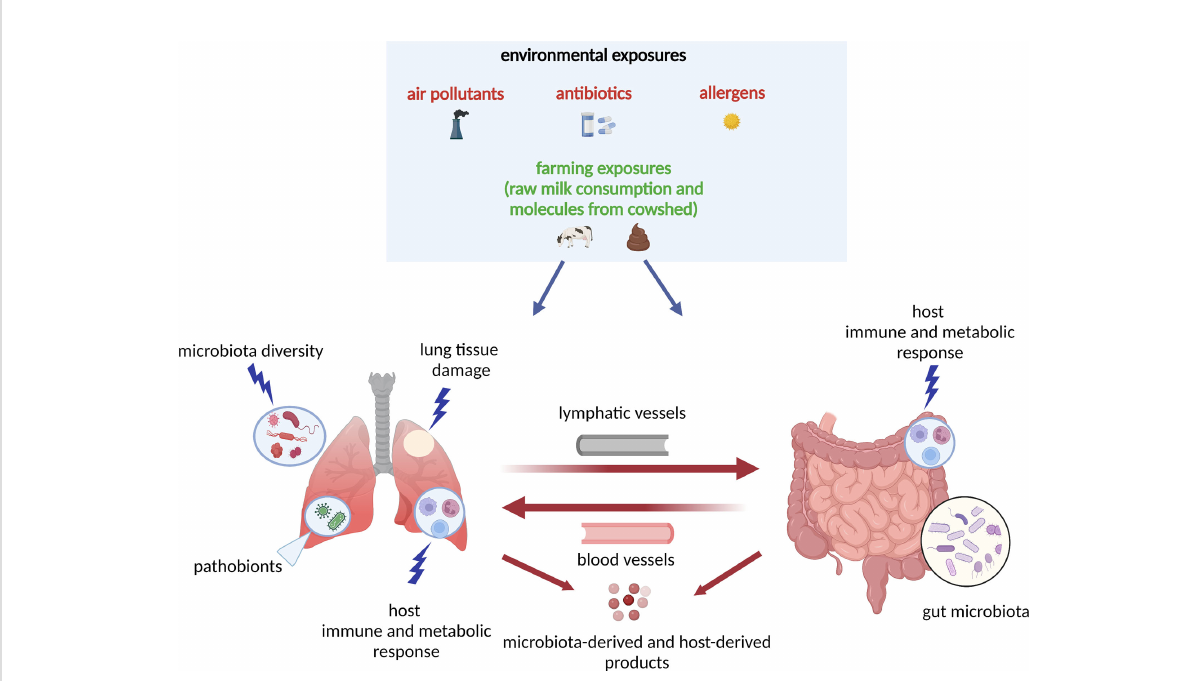
FIGURE 1 Model of the host – microbiota interaction during dysbiosis as a pathogenetic mechanism underlying asthma development: the “ gut-lung axis ” . A variety of environmental exposures, either protective (green color) or non-protective (red color) can trigger microbial dysbiosis (i.e., the alteration of the function and composition of the microbiota). In this model, in response to the non-protective environmental exposures (air pollutants, antibiotics, allergens), there is lung tissue damage and release of molecules that interact with host immune and metabolic pathways. The lung and gut microbiota diversity is perturbed, and there is increase in pathobionts (i.e., potentially disease-causing organisms that under normal circumstances act as symbionts) in both lung and gut tissues. In response to microbial dysbiosis, there is also increased activation of leukocytes and other innate-mediated soluble factors, which circulate through blood and lymphatic vessels and trigger adaptive immune responses with T H 1, T H 2, T H 17, Treg differentiation. All host- and microbiota ‐ derived (e.g., SCFAs, cytokines and chemokines) products act at the local (lung) or distal (gut) levels via circulation through blood and lymphatic vessels. The “ gut-lung axis ” refers to bidirectional crosstalk between these two mucosal sites of the body as described above. SCFAs, short-chain fatty acids; T H 2, T helper 2; T H 17, T helper 17; Treg, regulatory T